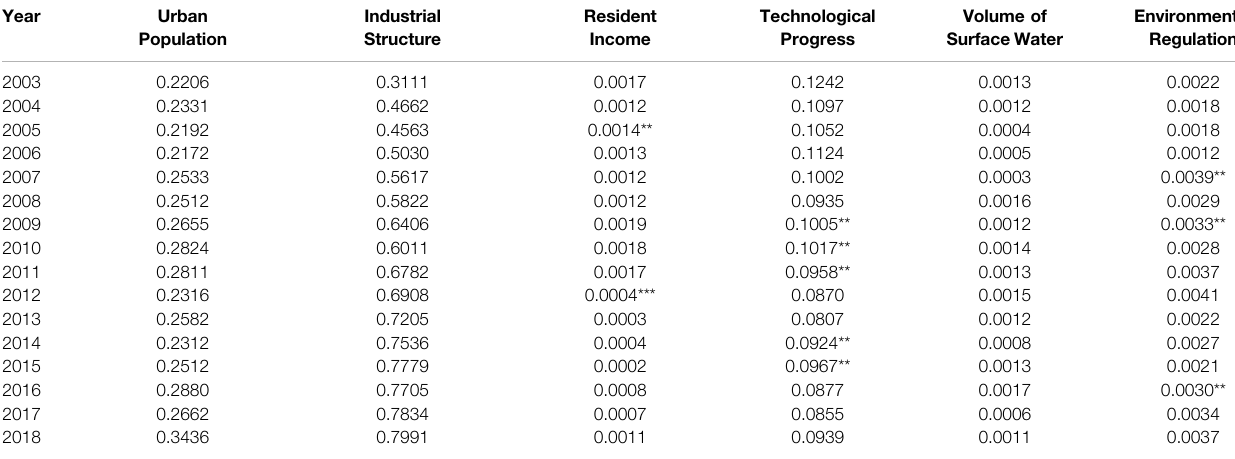
TABLE 5 | Analysis of UWUE using